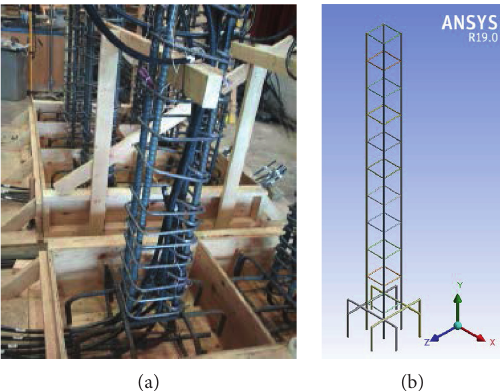
Figure 2: Reinforcement bar arrangement for CONV_20 RC column: (a) experiment carried out by Siba [20]; (b) AUTODYN FEA